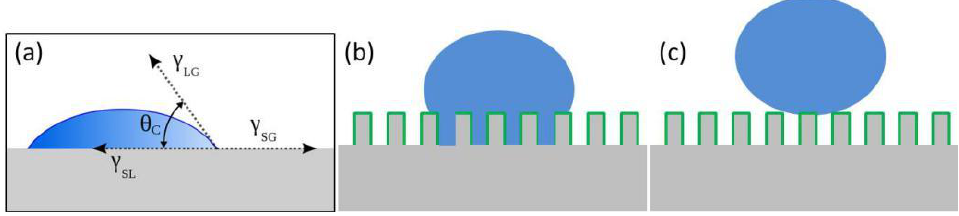
Figure 3. ( a ) Young’s model [34]; reproduced with permission from the American Chemical Society. ( b ) The Wenzel model: a water droplet penetrates into cavities [33]; reproduced with permission from Annual Reviews. ( c ) The Cassie–Baxter model: a water droplet sits on the top of structures [47]; reproduced with permission from the Royal Society of